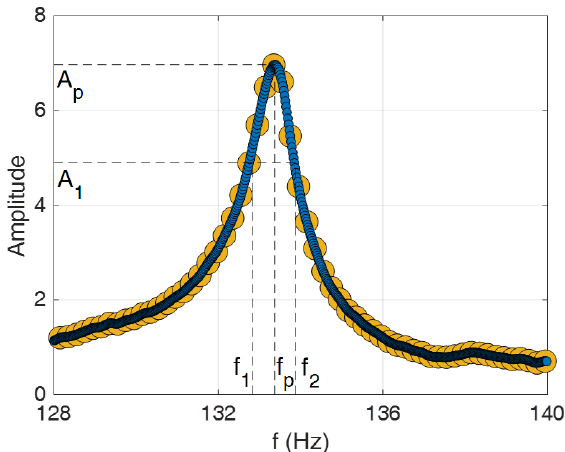
Figure 2. Example of fft of the vibration signal of a tennis racket (~134 Hz). Large yellow dots are the original fft points and the small blue dots represent the spline fitting used for damping estimation.